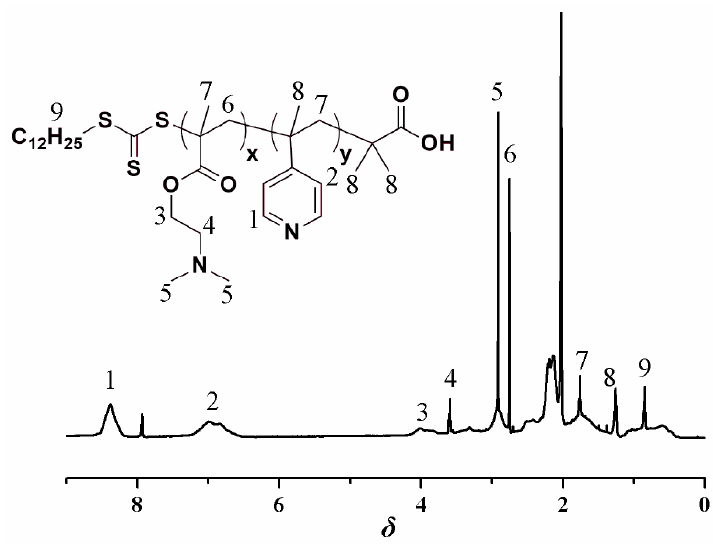
Figure 1. 1H NMR spectrum of P4VP-co-PDMAEMA (P4) in Acetone-d 6 .